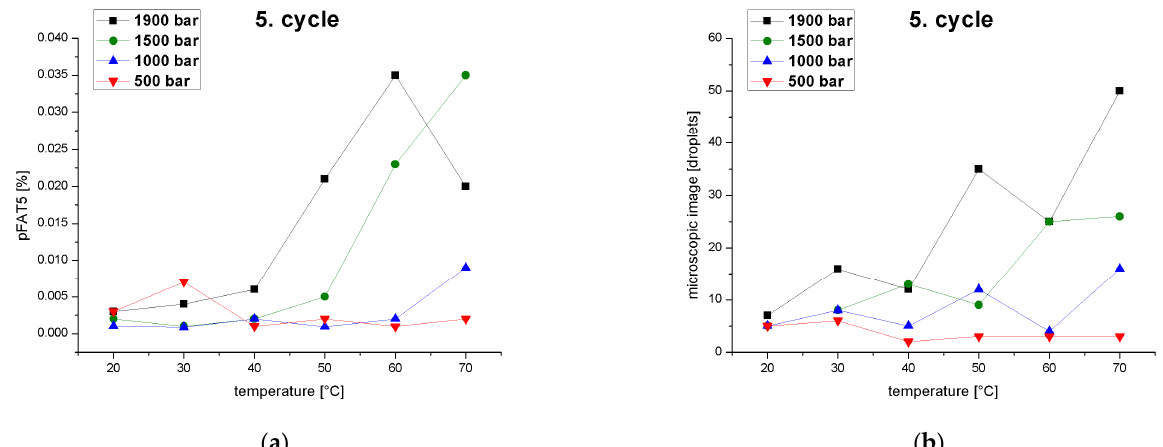
Figure 8. Effect of temperature and pressure on the pFAT5 value and droplet counts. ( a ) The pFAT5 value of the fifth homogenization cycle as a function of temperature at different operating pressures (500–1900 bar). ( b ) Droplet count as a function of temperature at different operating pressures (500–1900 bar).